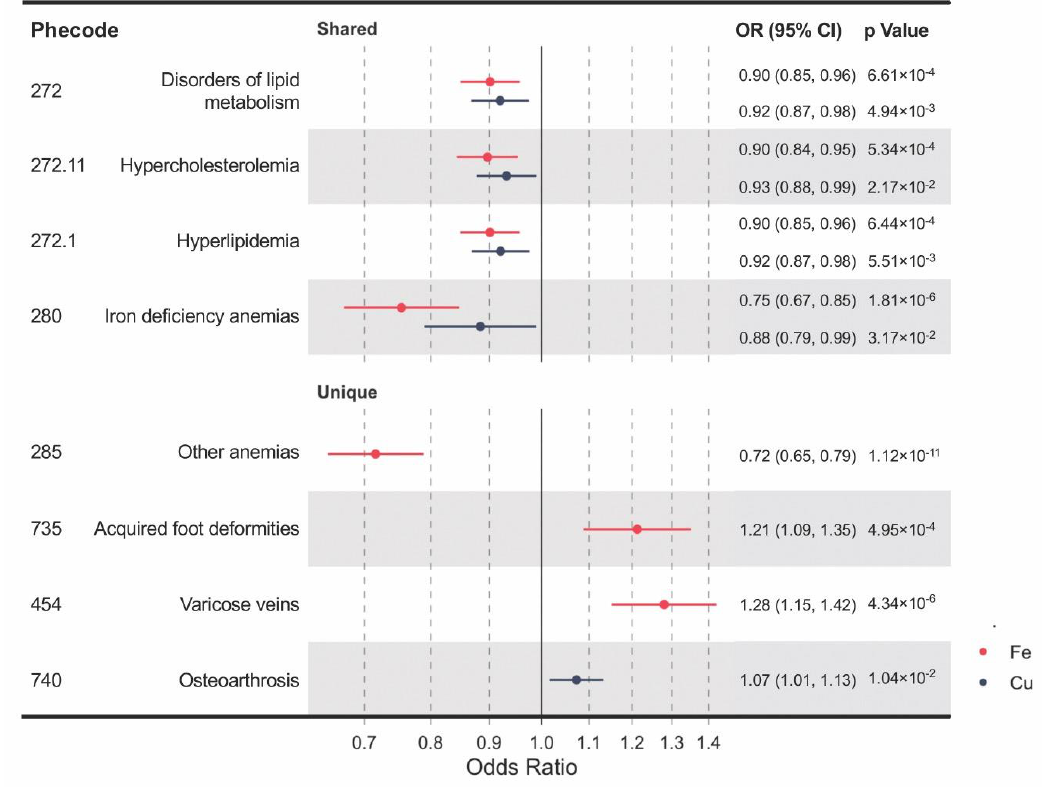
Figure 2. A forest plot showing significant mineral–outcome associations based on MR analysis. The causal estimates are from inverse-variance weighted (IVW) MR and have no indications of pleiotropy. The odds ratios (ORs) with their 95% confidence intervals (CIs) are scaled to a 1-SD increase in blood iron or copper level. Complete MR results are provided in Table